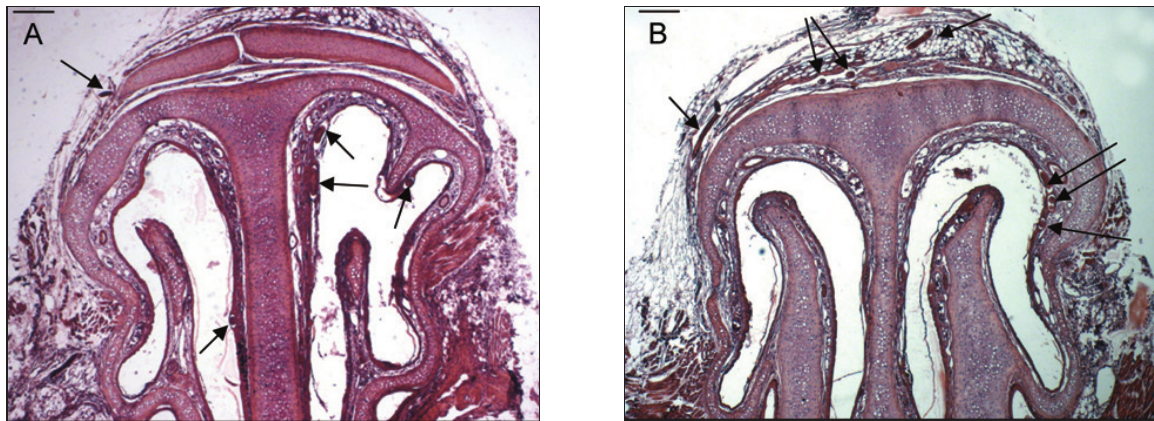
Fig. 3. – Two frontal sections of the nasal cavities at the level of the muzzle, showing the conchae projecting into the nasal cavities. A, on the left the median concha, and on the right the anterior and median conchae are visible. Arrows indicate the localization of five Trichosomoides nasalis . B, slightly posteriorly, only the median conchae are visible in the two cavities. Arrows indicate the localization of seven T. nasalis . Scale bars in μ m: A, B,